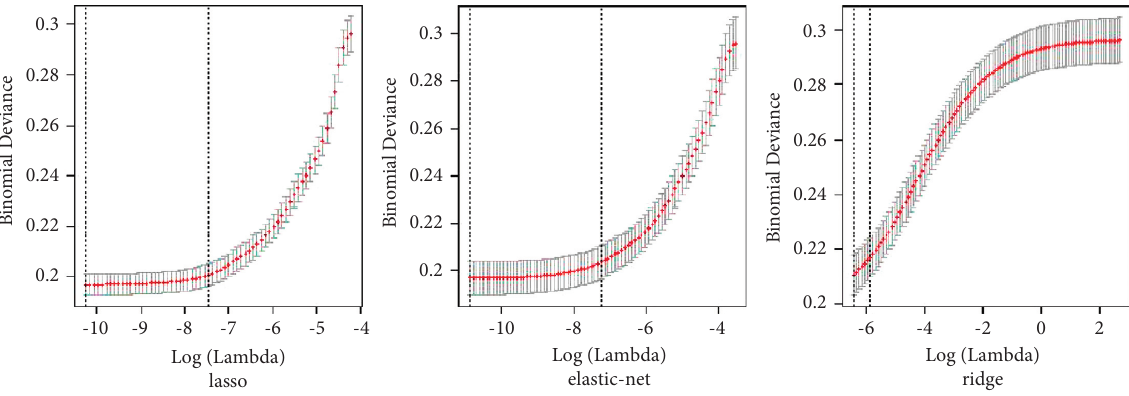
Figure 5: The error curve of ten-fold cross validation.